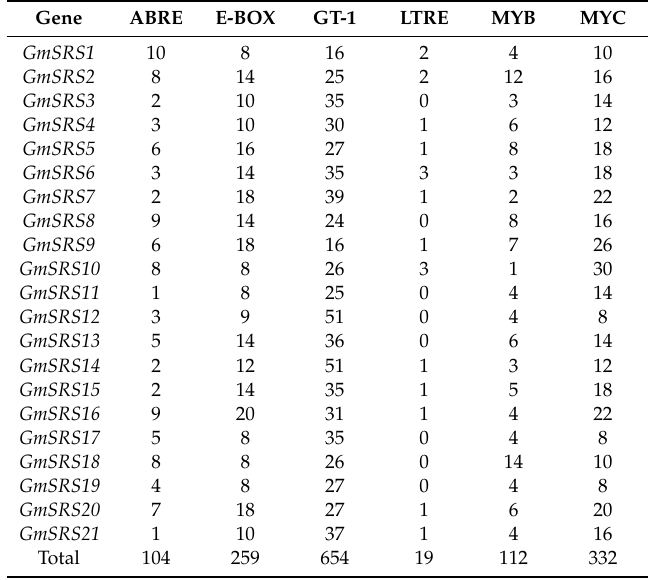
Table 2. The cis-acting elements in the promoters of soybean SRS genes.